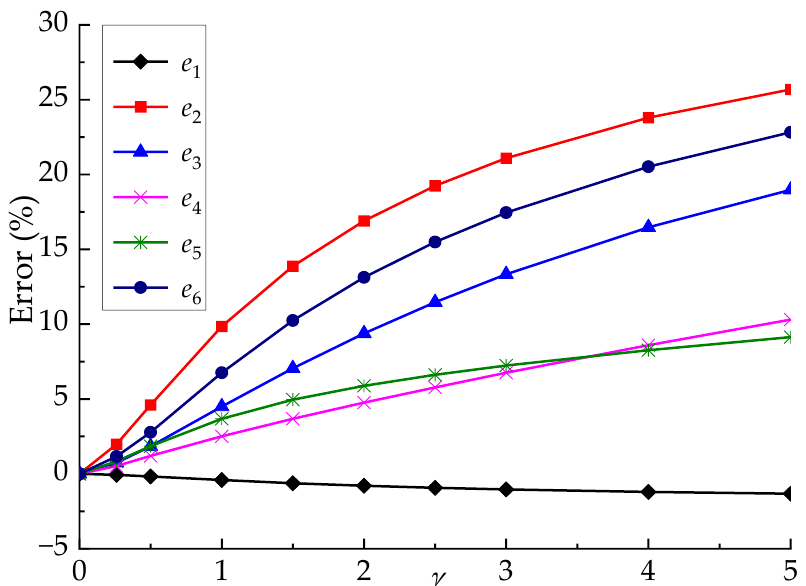
Figure 2. The percentage errors of the first six natural frequencies of the NAVMI factor solutions with respect to the Galerkin solutions for an entirely submerged ( μ = 1.0) elliptical cylinder ( b 0 / a 0 = 0.5), as the function of the cylinder – water density factor γ .